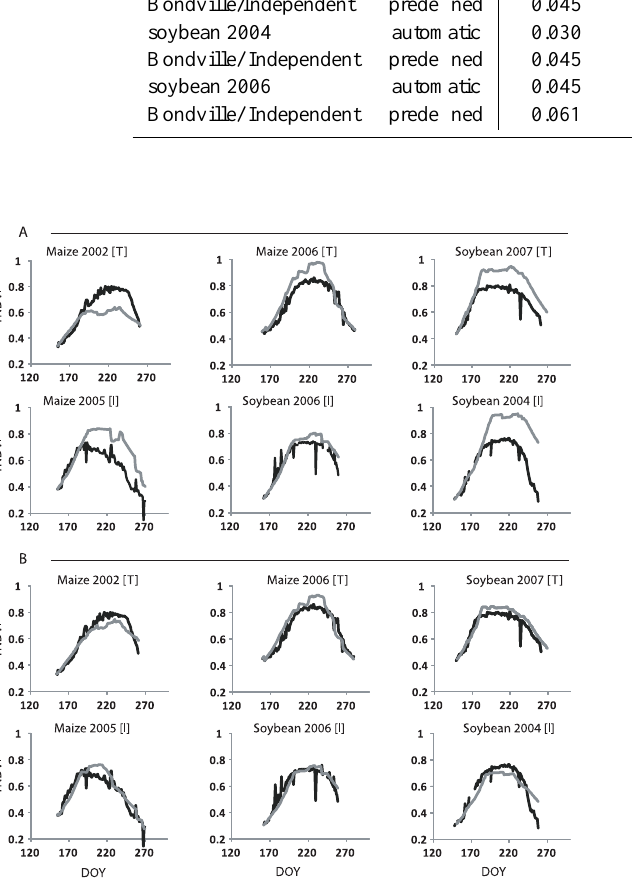
Fig. 2. Simulated and observed dynamics of TNDVI in test runs of the EDPM. Black line: observed TNDVI; gray line: modeled TNDVI. A: EDPM with automatic phenophase transition point es- timation; B: EDPM with prescribed phenophase transition points. [T] indicates data used for training; [I] indicates independent data used for